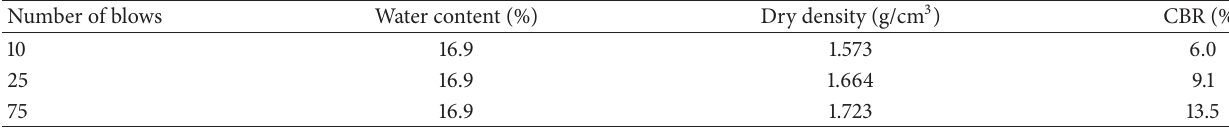
Table 7: CBR values of the three samples of soil without additives.